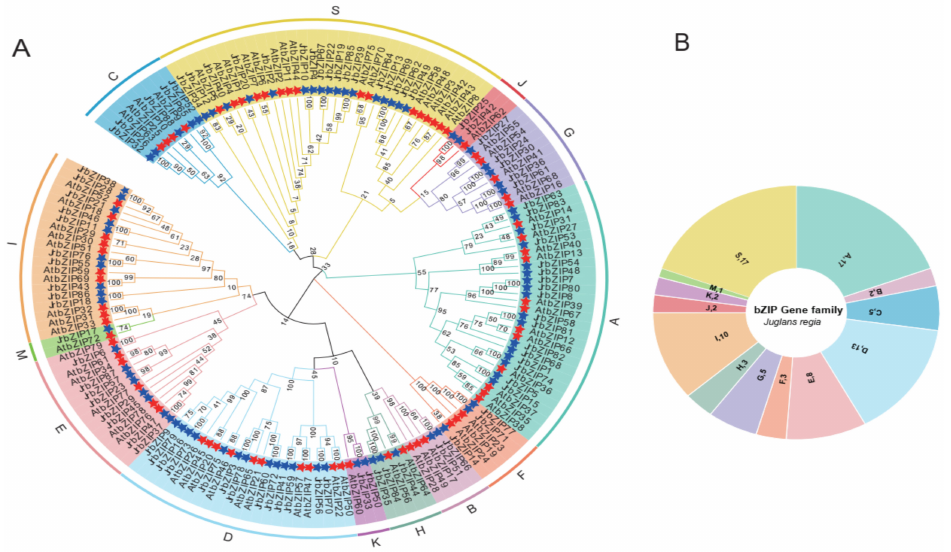
Figure 1. ( A ) Phylogenetic relationships among the identified bZIP proteins in Arabidopsis thaliana and Juglans regia L. The red stars indicate the At bZIP proteins, and the blue stars represent the Jr bZIP proteins. ( B ) The number of each group of the bZIP gene family of